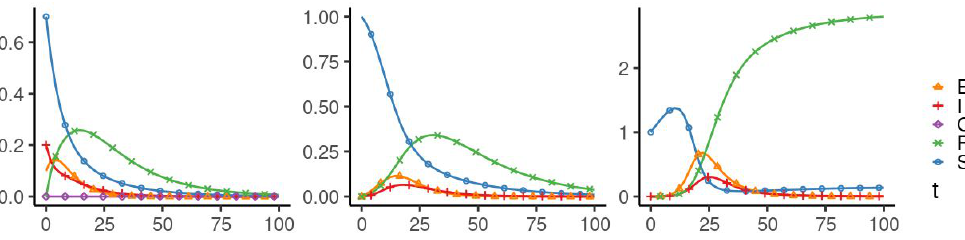
Figure 7. Experiment 1. Spread of the virus in three different clusters in a controlled